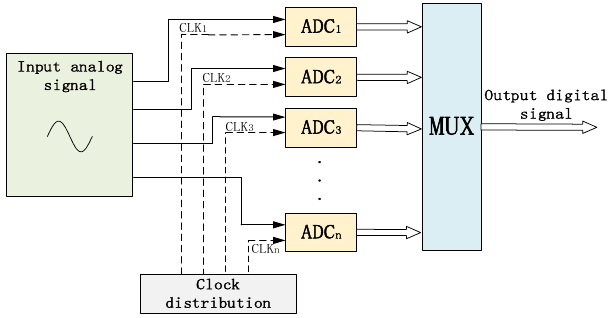
Figure 1. Working principle diagram of the TIADC system in an ideal state.